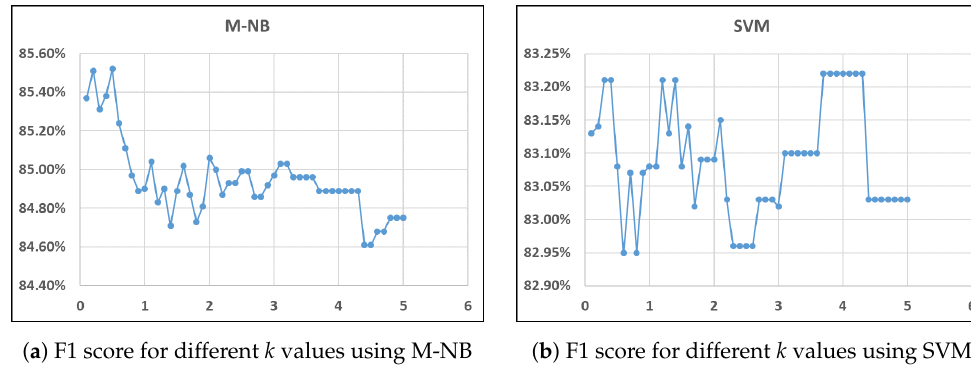
Figure 8. Results of all considered k values for MARSA (Social) dataset.